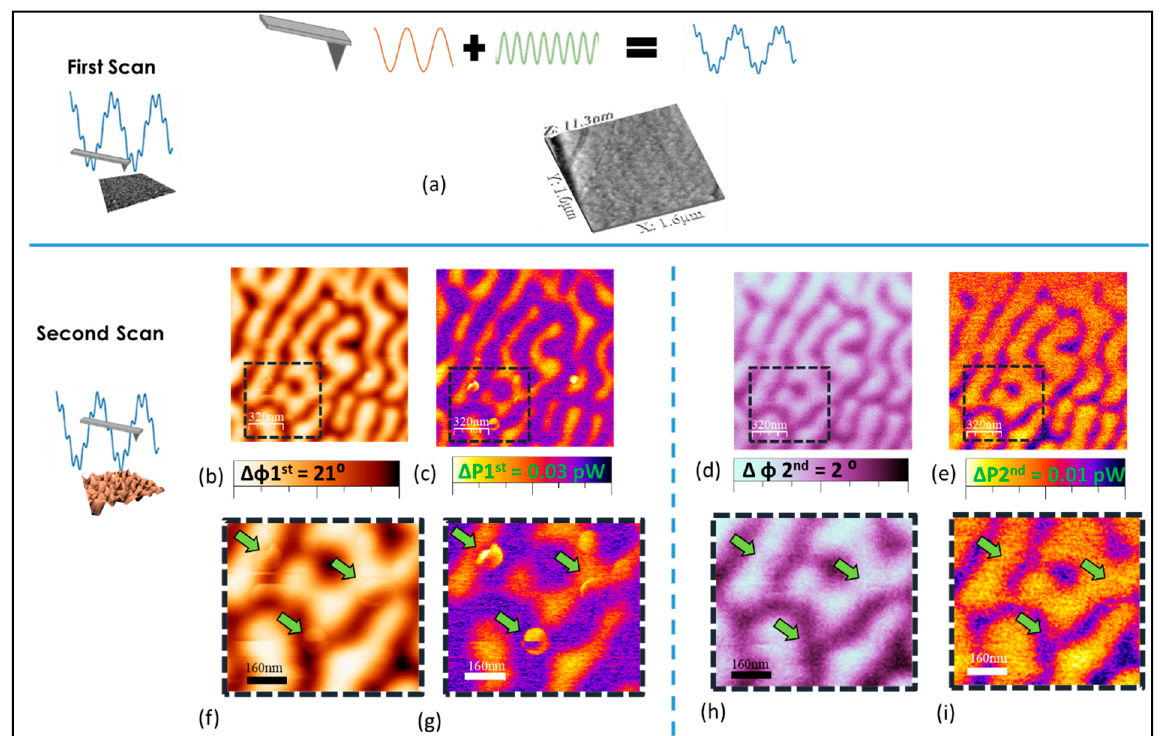
Figure 1. The upper panel corresponds to the first scan where the topography ( a ) is detected. The lower panel corresponds to the retrace scan where magnetic long-range interaction is dominant: ( b ) standard MFM signal corresponding to the phase of the 1st mode; ( c ) dissipation map corresponding to the 1st mode calculated by Equation (1). ( d , e ) phase and dissipation map of the 2nd mode. Images size: 1.6 μ m × 1.6 μ m. A 1 = 20 nm. A 2 = 5 nm. Z lift distance = 30 nm. ( f ) is a zoom of the MFM image ( b , g ) is a zoom of the dissipation map corresponding to the 1st mode ( c ) where rings and stronger bright contrast that correspond to dissipation-related features can be easily distinguished superposed to the magnetic domain configuration (marked with green arrows). ( h , i ) are the equivalent zooms of the images corresponding to the second mode ( d , e ) where it is not clear the presence of the dissipation related features at the same positions (green arrows).